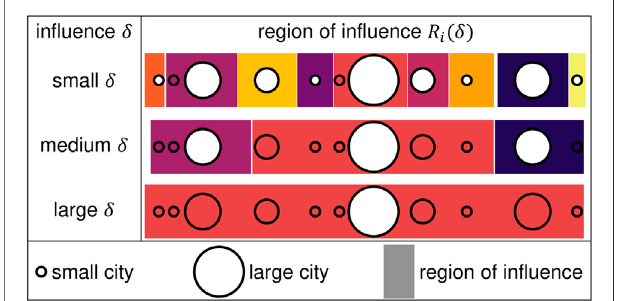
FIGURE 1 | Scheme for constructing the region of in fl uence R i ( δ ) of cities. Cities are represented by discs, according to their size. For a short in fl uence distance δ (top) many small regions are formed, represented by different colour ribbons. The centre of each region is the white disc. Some of the cities which were a centre for small values of the in fl uence distance δ , become part of the region of in fl uence of another city for larger values of δ